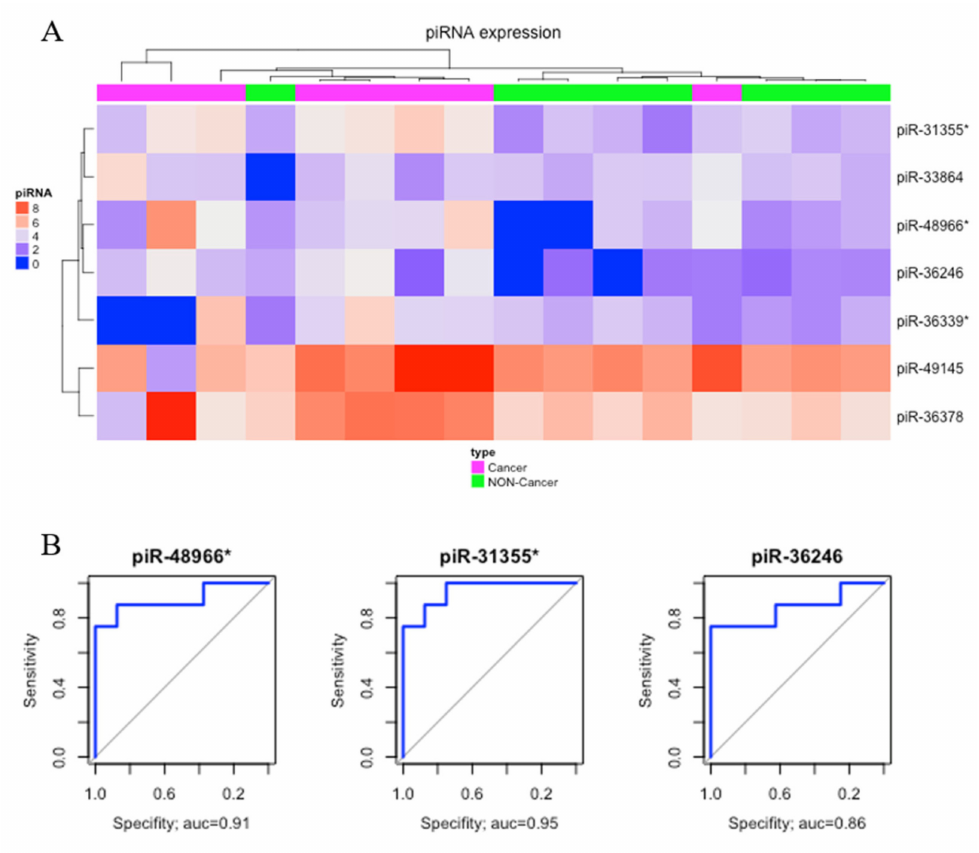
Figure 2. Differentially expressed piRNAs between gastric cancer and non-cancer. ( A ) Hierarchic clustering heat map of differentially expressed piRNAs ( p -value < 0.05; | fold-change | > 3). ( B ) The receiver operating characteristic (ROC) curve analysis of piRNAs that presented AUC >